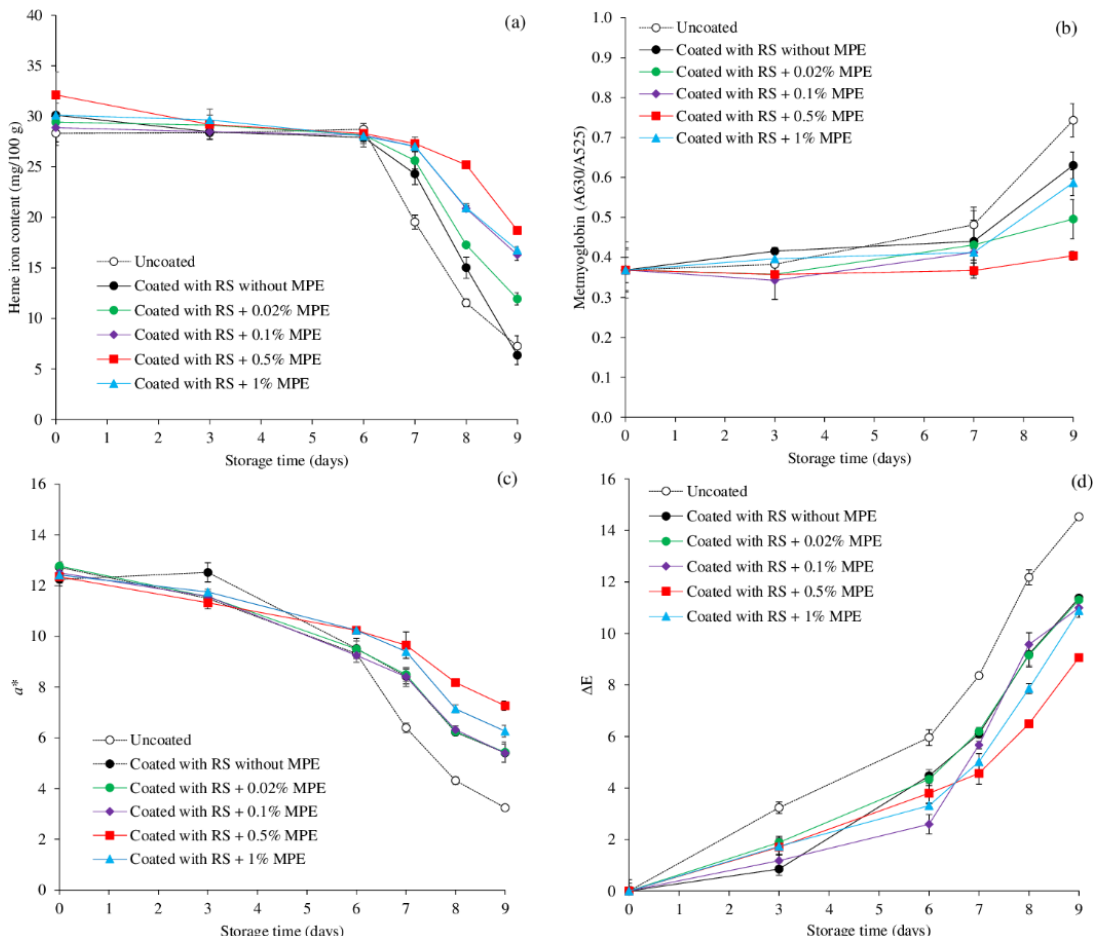
Figure 4. Changes in heme iron content ( a ), metmyoglobin ( b ), a * value ( c ), and total color difference Δ E ( d ) of mackerel slices over the course of storage at 4 °C as influenced by coating with rice starch (RS) containing Mon-pu extract (MPE) at different concentrations. Bars represent standard deviation from triplicate determinations.